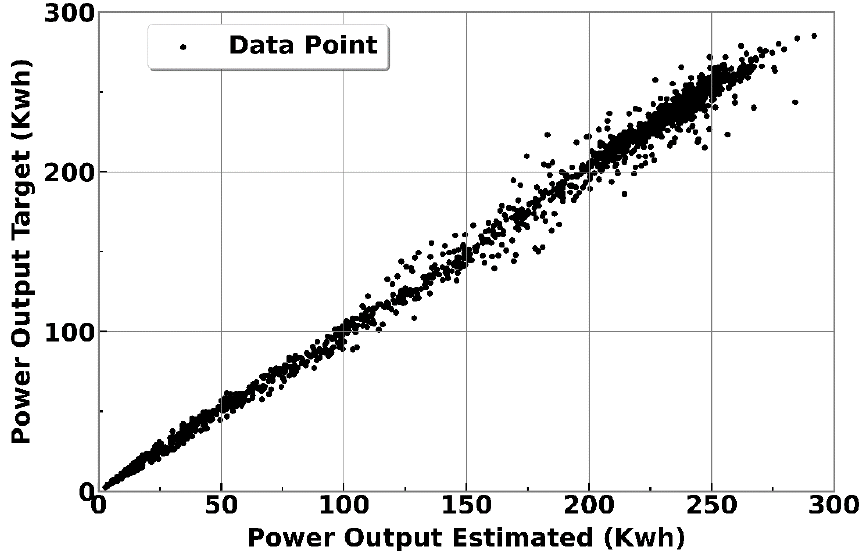
Figure 11. Performance of the neural network on testing set.